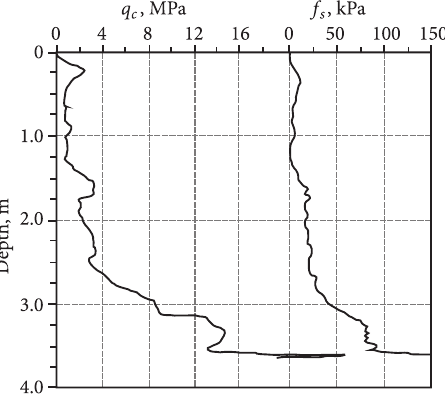
fig. 5. Results of cone penetration test performed at laboratory pit